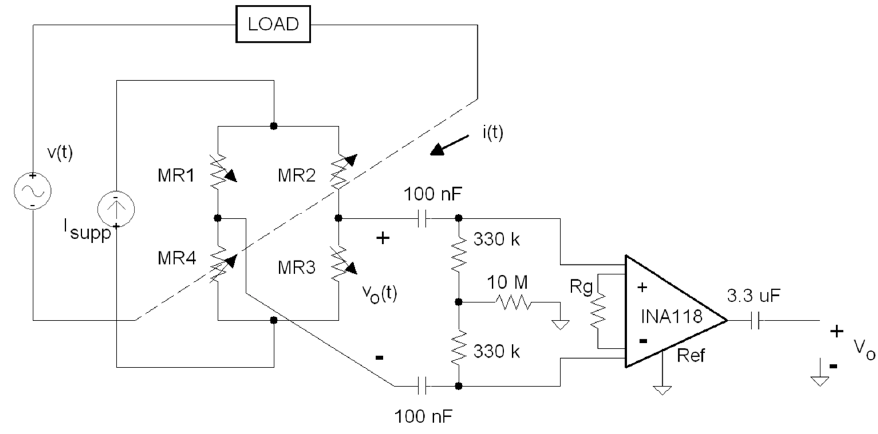
Figure 7. Signal conditioning electronics of the current channel.